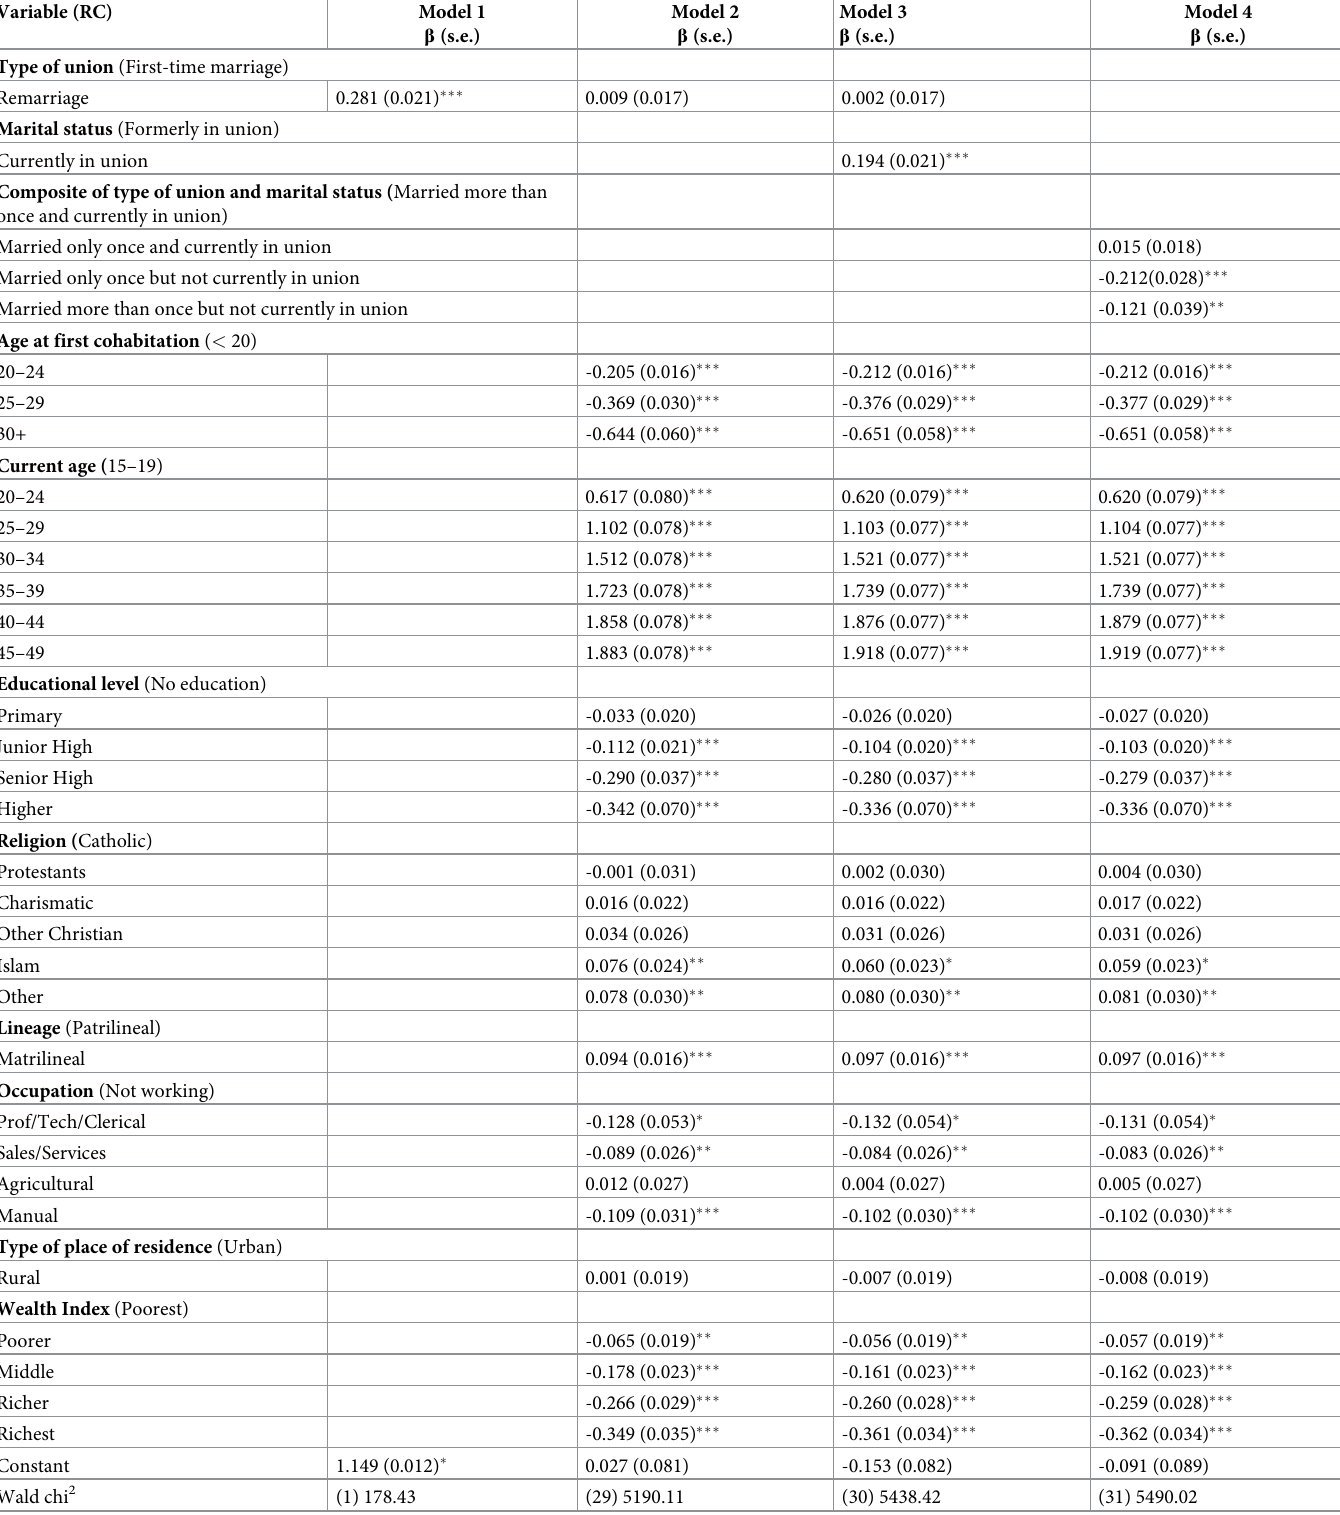
Table 3. Predictors of fertility by type of